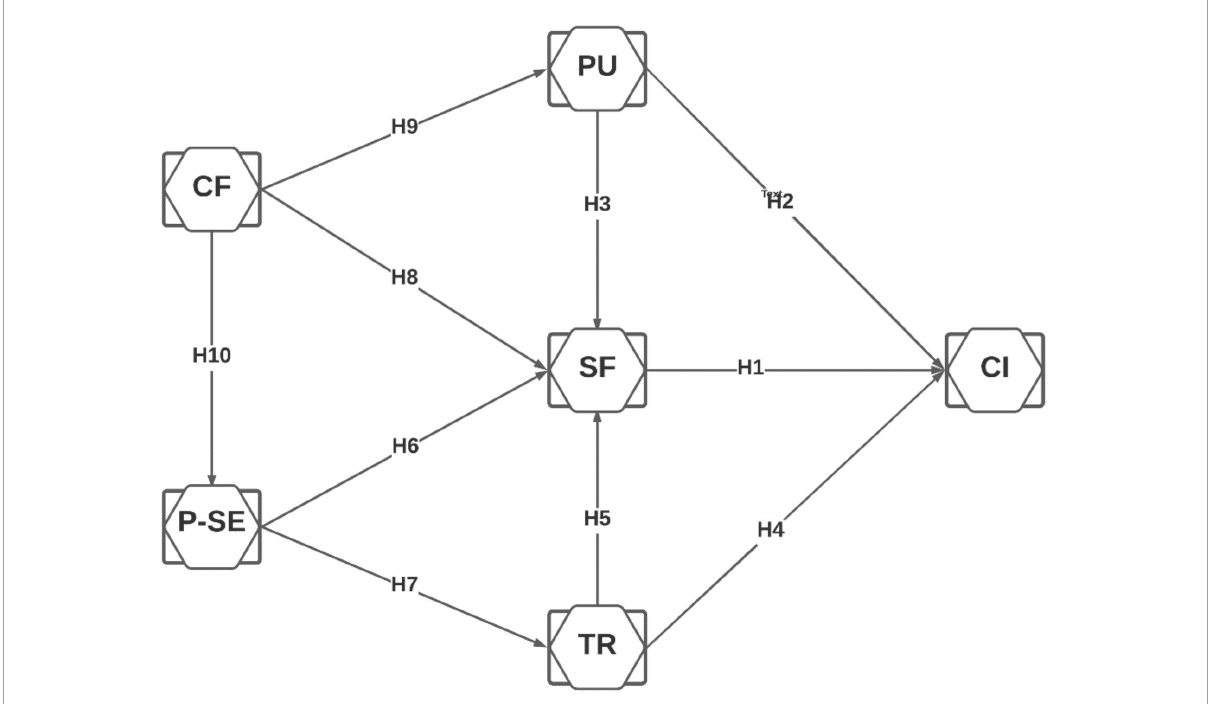
FIGURE1 Research model. CF, confirmation; PU, perceived usefulness; SF, satisfaction; P-SE, perceived security; TR, trust; CI, continuous